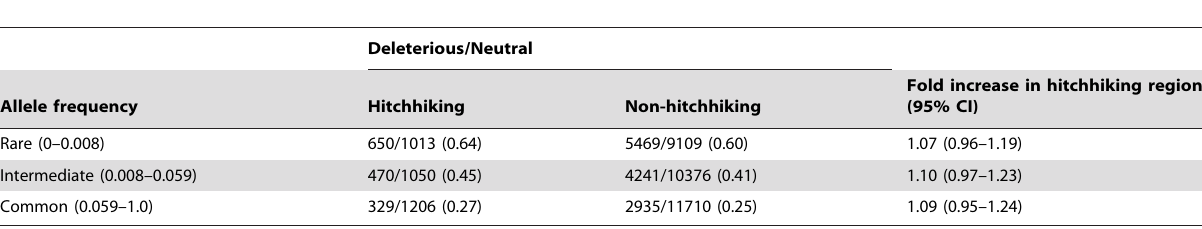
Table 1. The ratio of deleterious to neutral SNPs at different allele